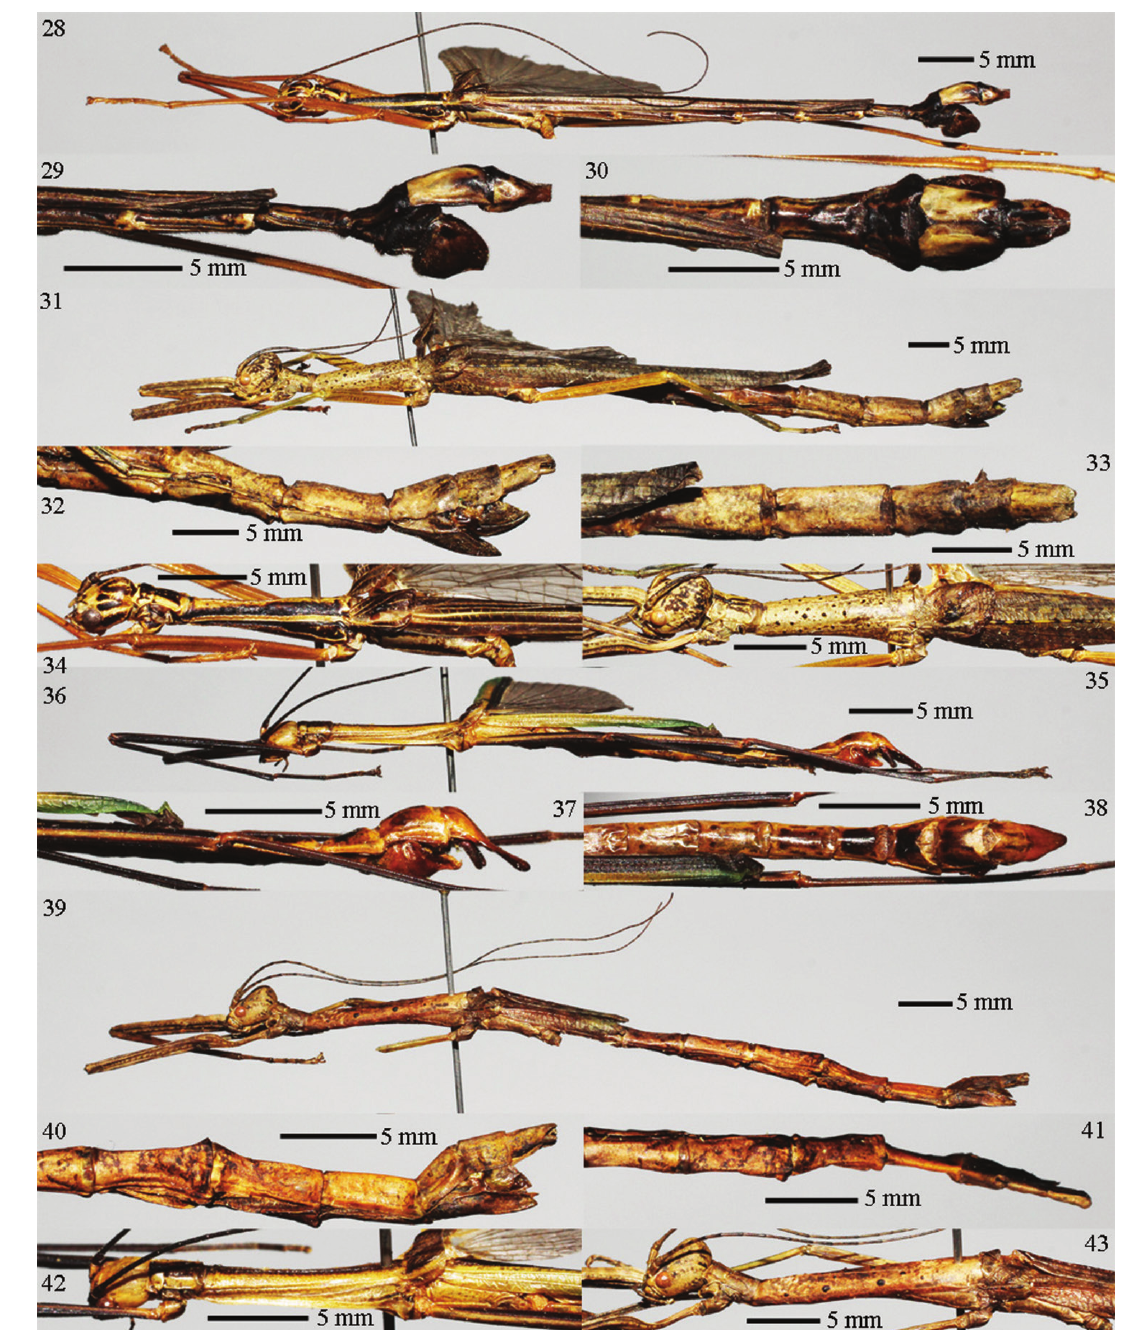
Figs 28–43. Parasinophasma spp. 28. P . bresseeli sp. n.: ♂ , habitus. 29. P . bresseeli sp. n.: ♂ , apex of abdomen, lateral view; 30. P . bresseeli sp. n.: ♂ , apex of abdomen, dorsal view; 31. P . bresseeli sp. n.: ♀ , habitus; 32. P . bresseeli sp. n.: ♀ , apex of abdomen, lateral view; 33. P . bresseeli sp. n.: ♀ , apex of abdomen, dorsal view; 34. P . bresseeli sp. n.: ♂ , head and thorax, dorsolateral view; 35. P . bresseeli sp. n.: ♀ , head and thorax, dorsolateral view; 36. P . constanti sp. n.: ♂ , habitus; 37. P . constanti sp. n.: ♂ , apex of abdomen, lateral view; 38. P . constanti sp. n.: ♂ , apex of abdomen, dorsal view; 39. P . constanti sp. n.: ♀ , habitus; 40. P . constanti sp. n.: ♀ , apex of abdomen, lateral view; 41. P . constanti sp. n.: ♀ , apex of abdomen, dorsal view; 42. P . constanti sp. n.: ♂ , head and thorax, dorsolateral view; 43. P . con- stanti sp. n.: ♀ , head and thorax, dorsolateral view.